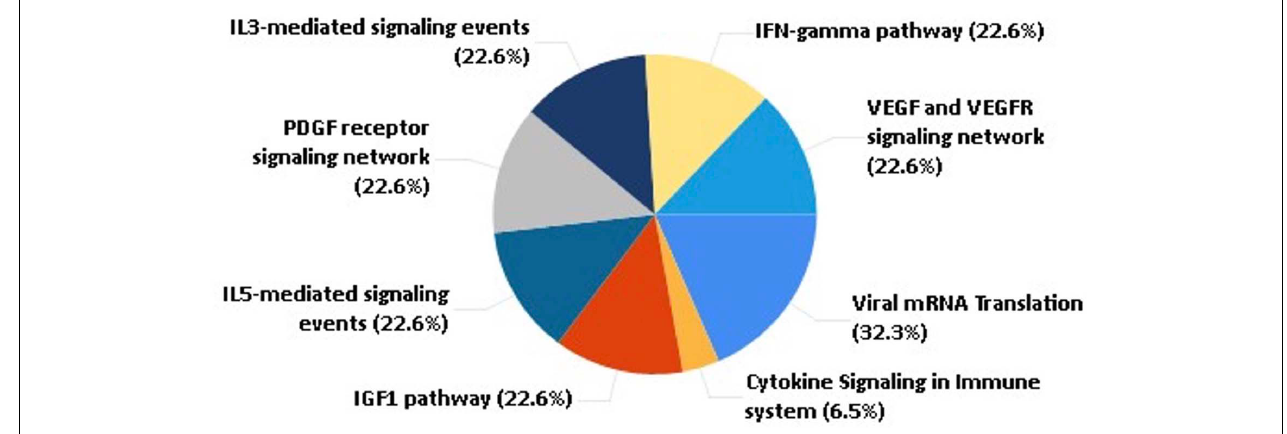
FIGURE 3 | Pathway analysis of the selected 45